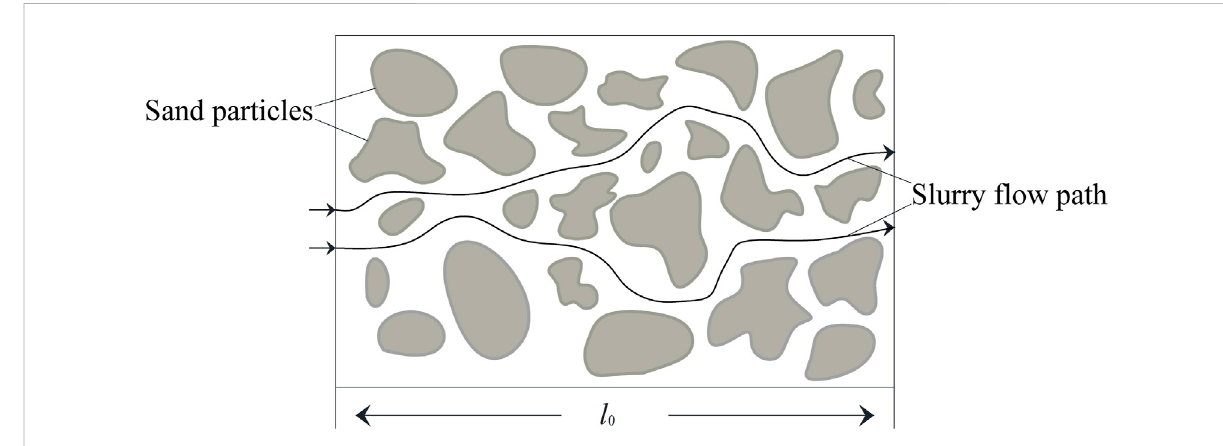
FIGURE 1 Schematic diagram of porous medium seepage